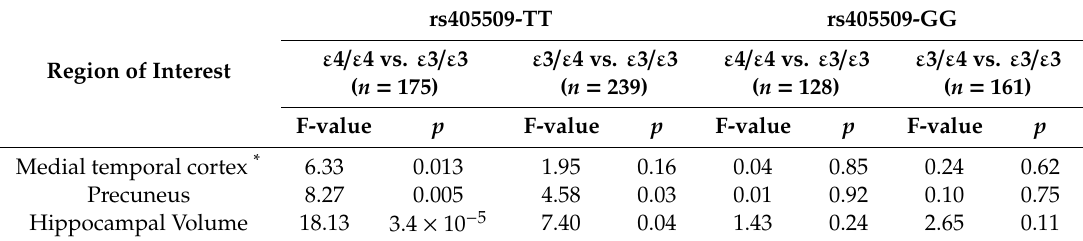
Table 3. Modifying e ff ect of rs405509 genotype on the association of APOE ε 4 with cortical atrophy in European ancestry ADNI (Alzheimer’s Disease Neuroimaging Initiative)